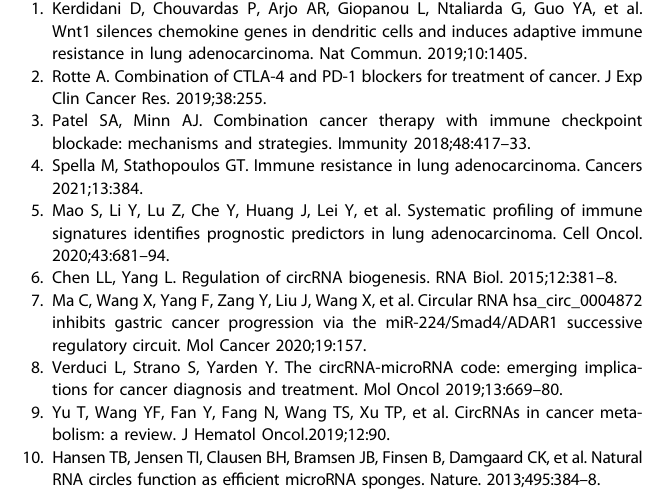
Statistical analysis All data analyses were interpreted by GraphPad prism 7.0 version (GraphPad Software, CA, USA). The results are shown as mean ± standard deviation (SD). Statistical analyses were assessed through Student ’ s t test or one-way ANOVA. Pearson analyses were carried out to assess the correlation. Statistical signi fi cance was set at P < 0.05. There is no estimate of variation in each group of data and the variance is similar between the groups. No statistical method was used to predetermine sample size. The investigators were not blinded to allocation during experiments and outcome assessment. All data were expected to have normal distribution. None of the samples/animals was excluded from the experiment.